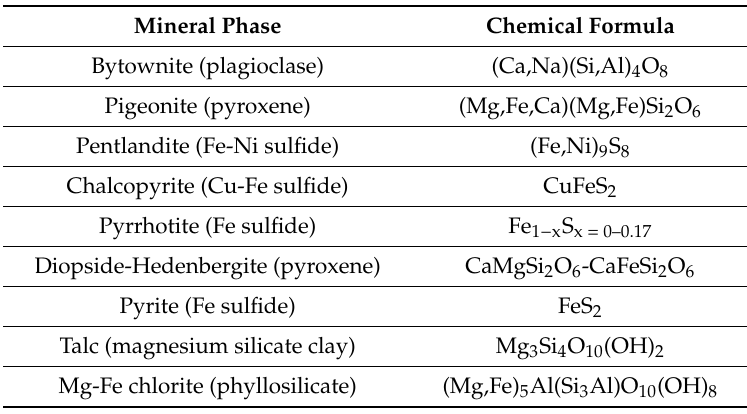
Table 4. Chemical formula of the main mineralogical content observed in the rendered PGE1a TIMA image according to the online Mineral Database [24].